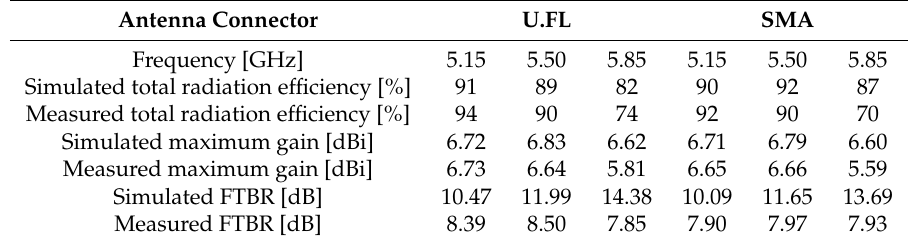
Figure 10. Comparison between simulated and measured gain of the measured antennas in free space. Table 1. Radiation efficiency, broadside gain and front-to-back ratio (FTBR) of the measured